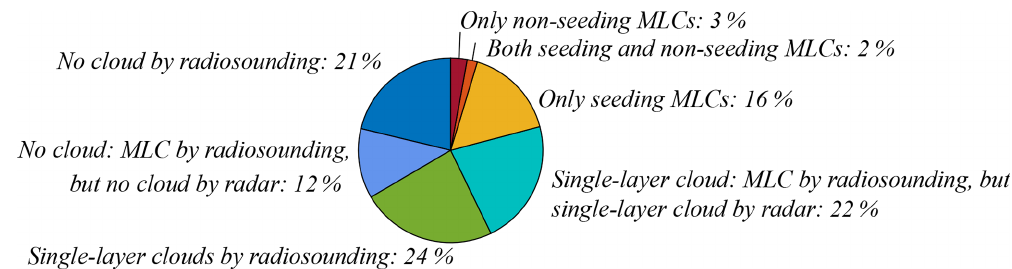
Figure A2. Cloud occurrence derived from using both radiosonde and radar for detection. For the radiosonde data the measurement un- certainty is considered to be − 5% relative humidity over the whole radiosonde profile. Seeding and non-seeding is calculated using an ice crystal of the size r = 400µm. The values are rounded to zero decimal places.